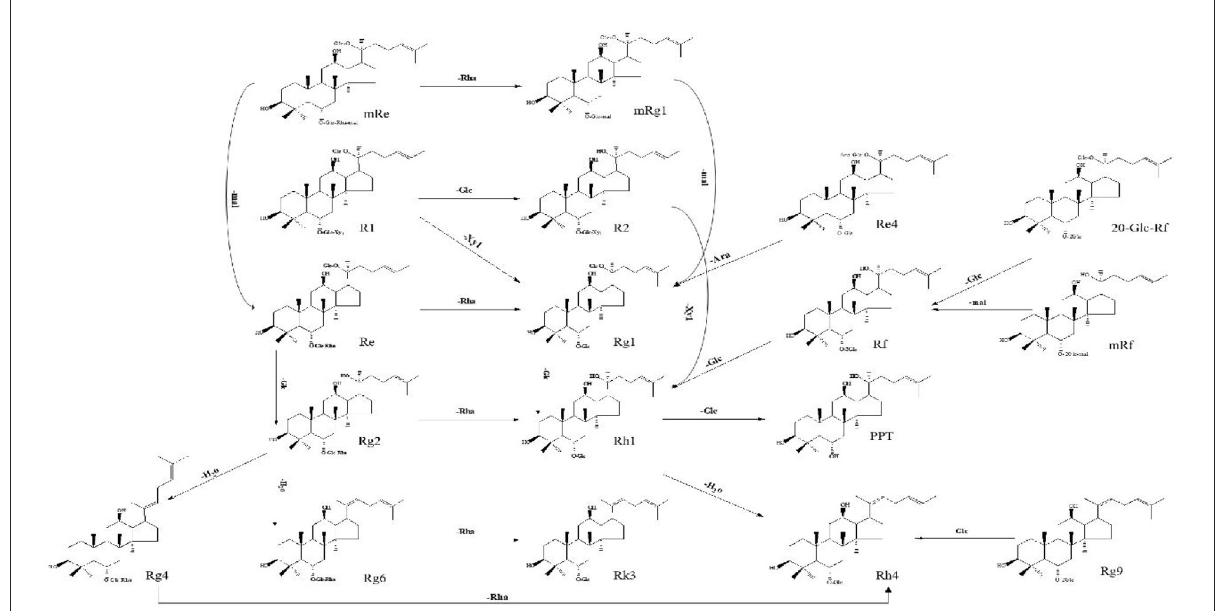
FIGURE5 Possible transformation pathways of PPT-type ginsenosides under the action of GH.